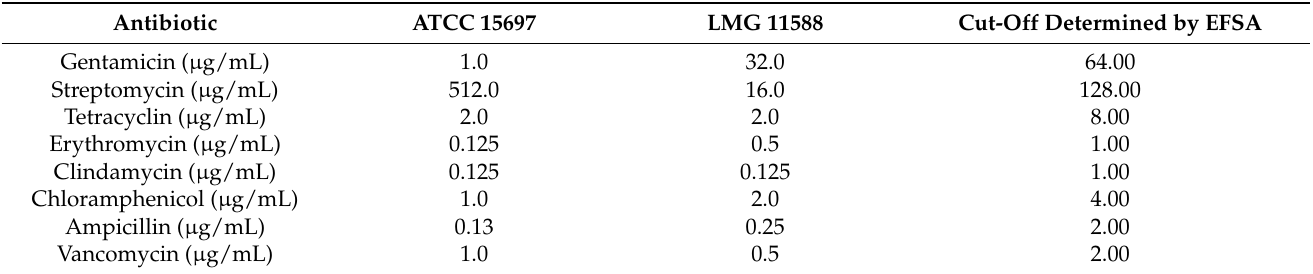
Table 4. Phenotypic resistance of B. infantis ATCC 15697 and LMG 11588 to relevant antibiotics as determined by EFSA. Minimal inhibitory concentrations (MICs) were determined using the microdilution method and are expressed in µ g/mL.